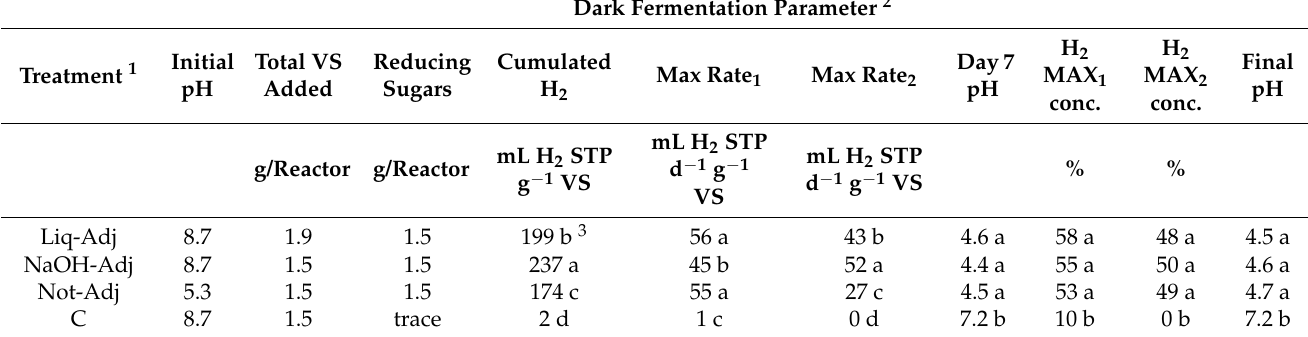
Table 2. Two-cycle dark fermentation parameters of the hydrogen production from giant reed hydrolysates in comparison with not treated and not hydrolyzed